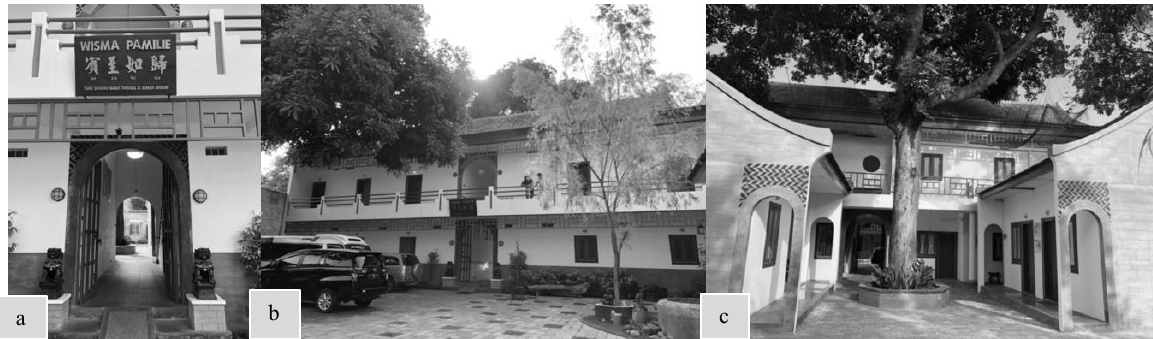
Figure 5. The new two-story building for homestay: (a) the gate to the homestay called Wisma Pamilie, (b) the front façade of the new two-story building for homestay, and (c) the backside of the new oen and two-story building for homestay